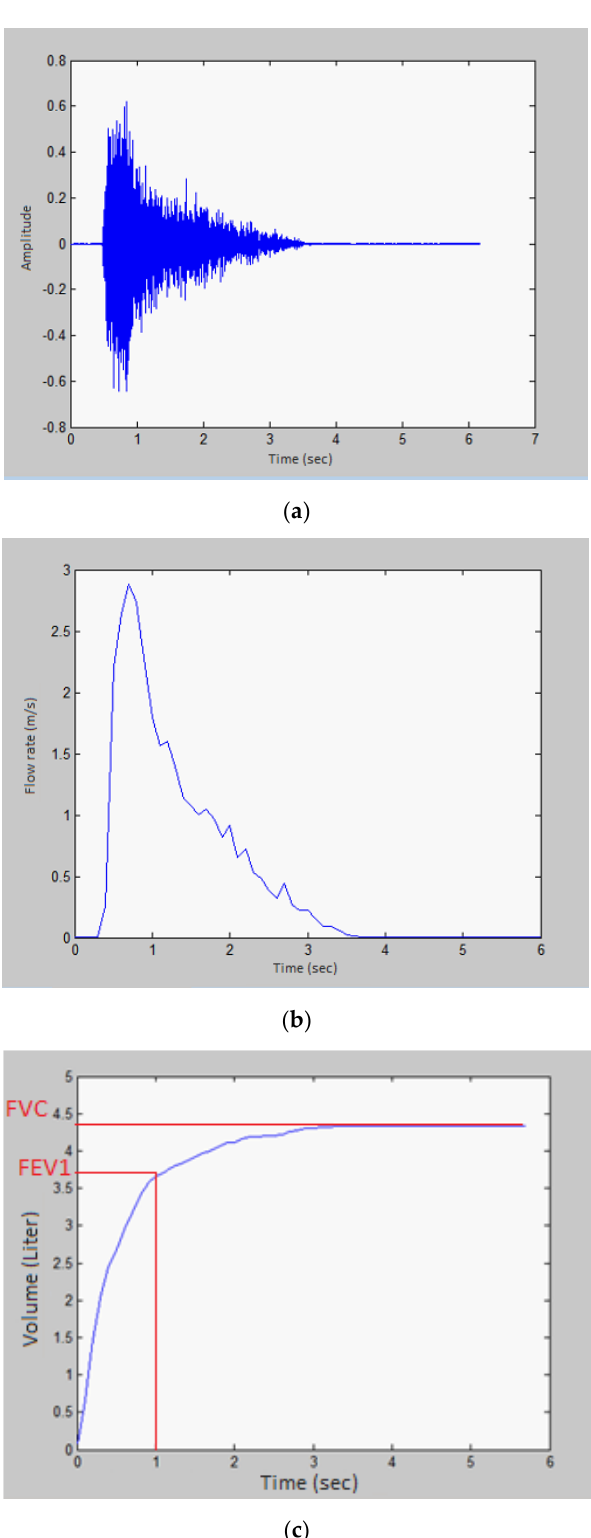
Figure 7. Signal sample and analysis graphs. ( a ) Exhalation signal of the sample. ( b ) Flow rate vs. Time. ( c ) Volume vs. Time.